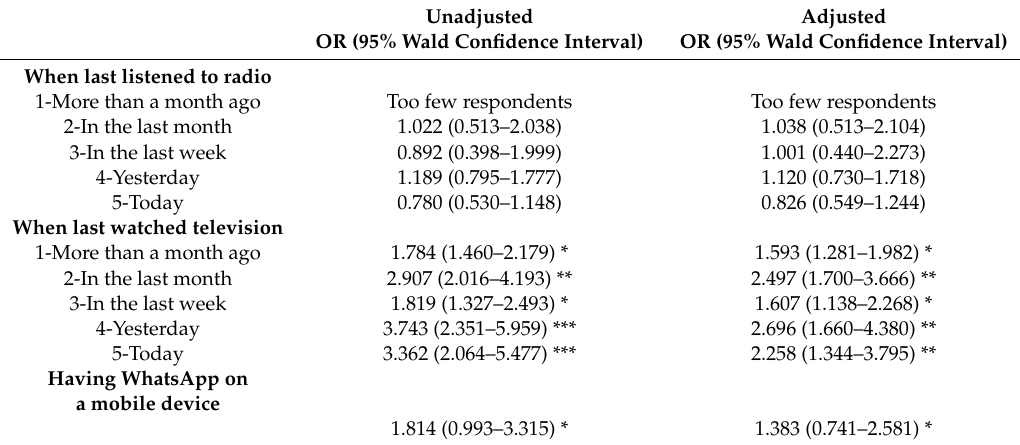
Table 4. Need for soap when washing hands knowledge indicators associated with media access.